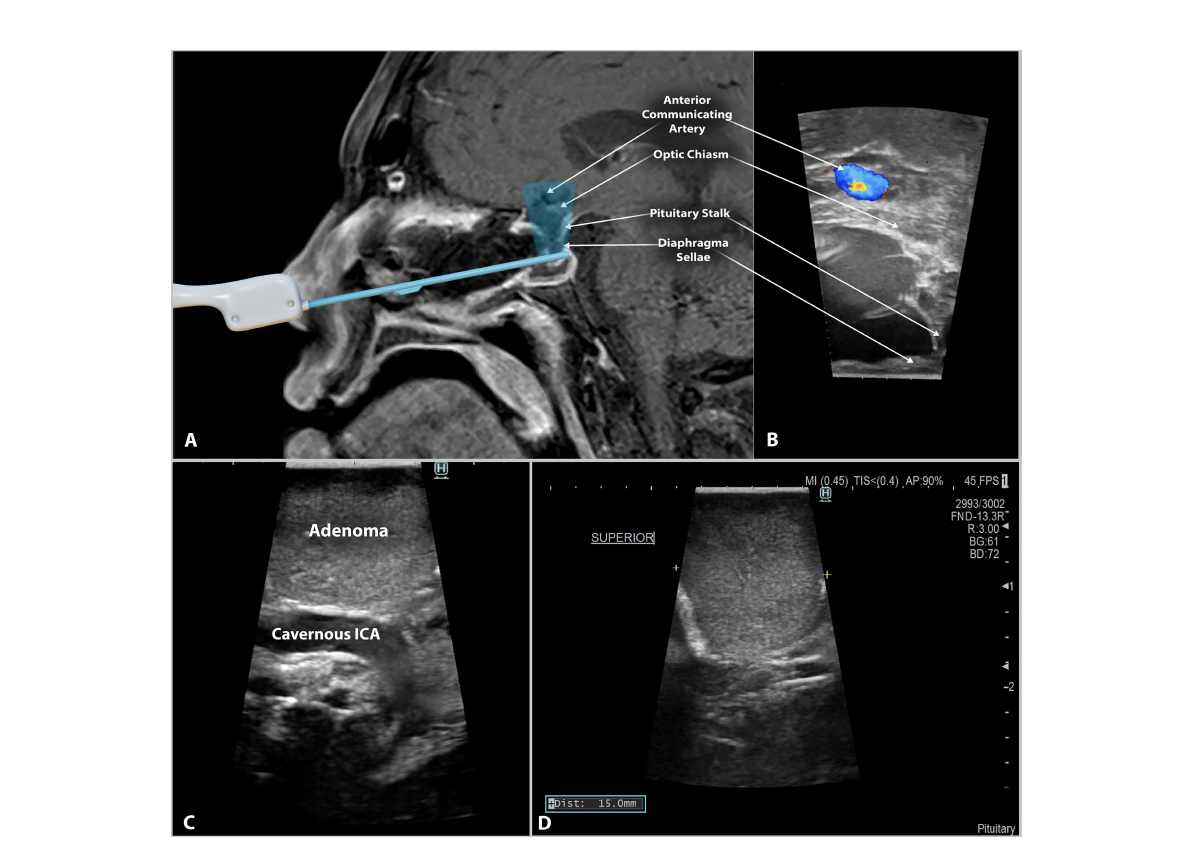
FIGURE 1 Side- fi ring intraoperative ultrasound in endoscopic endonasal pituitary surgery. (A) Schematic image depicting the scanning window of the side- fi ring ultrasound transducer. A digital ultrasound probe model is superimposed onto a T1 post-gadolinium MRI. (B) Intraoperative ultrasound image from the same patient showing intraoperative imaging of the surrounding parasellar anatomy. During image acquisition, the probe tip was abutted to the inferior surface of the diaphragma sellae, as demonstrated in Figure 1A. (C) Side- fi ring IOUS image showing pituitary adenoma tissue and the location of the cavernous segment of the Internal Carotid artery (cavernous ICA). The IOUS probe is directed laterally within the sella turcica. This image demonstrates the ability to identify critical structures and their relationship to the tumor tissue. (D) IOUS can be used to obtain tumor size data intraoperatively. The yellow symbols (+) in the above image indicate the location of the measurement, with the results displayed in the bottom left